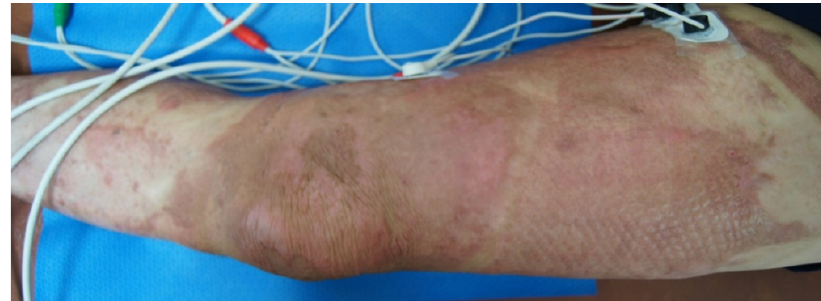
Figure 1. Pain scrambler therapy on scar pain site in burn patients.